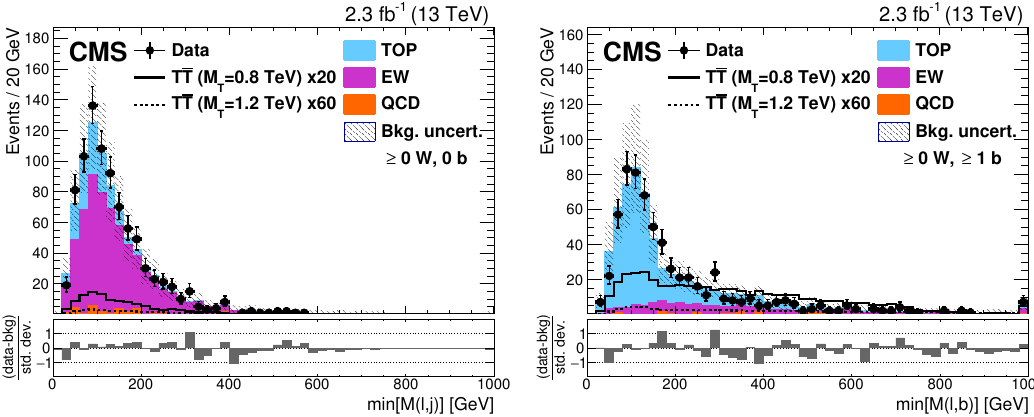
Figure 7 . Distributions of min[ M ( ‘; j )] in events without b-tagged AK4 jets (left) and min[ M ( ‘; b)] in events with (cid:21) 1 b-tagged AK4 jets (right) in the boosted W channel with all categories combined. Also shown are the distributions of TT signal events with T quark masses of 0.8 and 1.2 TeV, scaled by factors of 20 and 60, respectively. The uncertainty in the background includes the statistical and systematic uncertainties described in section